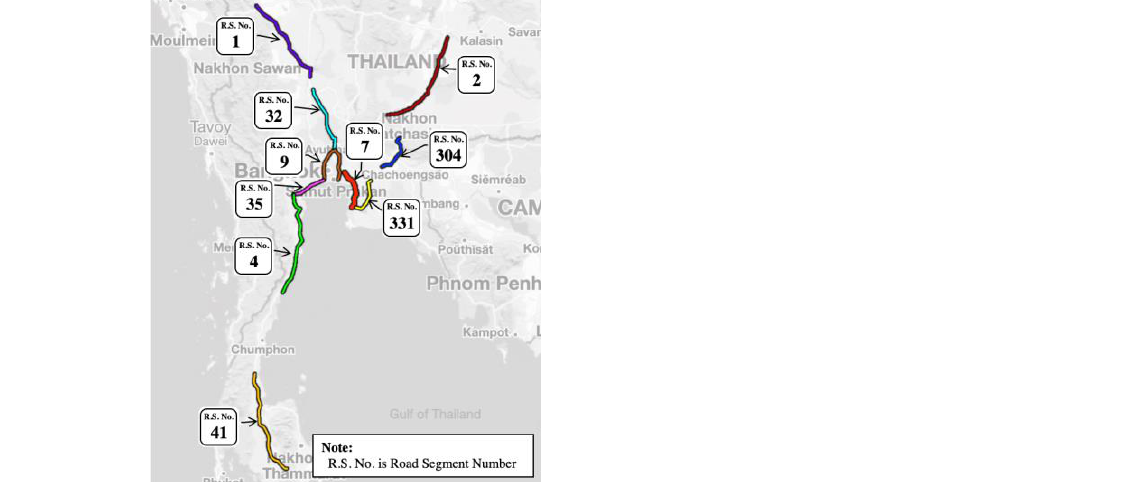
Figure 3. Visualization of polylines of the selected highway sections on a map of Thailand. Next, we used the locations of each truck in the GPS dataset to map them to the road segments and selected only trucks that passed through the beginning point and the end point of each road segment. In this case, there were about a hundred million GPS data entries. Since the timestamp of each truck was found at the beginning point and the end point of a road segment, we were able to calculate the travel time of each road segment, as shown in Table 1. In addition, the stopping times, which were calculated from a dura- tion of longer than 20 min in the same location, were excluded. Table 1 shows example data for highway number 1, where each entry is the average travel time from every begin- ning hour. Thus, this dataset can be viewed as time-series data with an hourly sampling rate. For example, the first data row of Table 1 means that trucks entering the starting point of the road segment highway number 1 during 00:00 and 00:59 took an average travel time of 18,421.14 s (about 5 h and 7 min) to the end point of that road segment. To better understand the dataset, the average hourly travel time of trucks on highway num- ber 1 in 2019 is plotted in Figure 4. In addition, the processed data are summarized in Table 2. There were 81,068 unique trucks with 2,010,270 trips and an average travel time of 203.04 min. Table 1. Average travel time in seconds on a road at every hour of each day in 2019. It is noted that the date format is YYYY-MM-DD where YYYY is a year, MM is a month, and DD is a day. Table 2. Summary of the data of trips passing through the 10 selected road